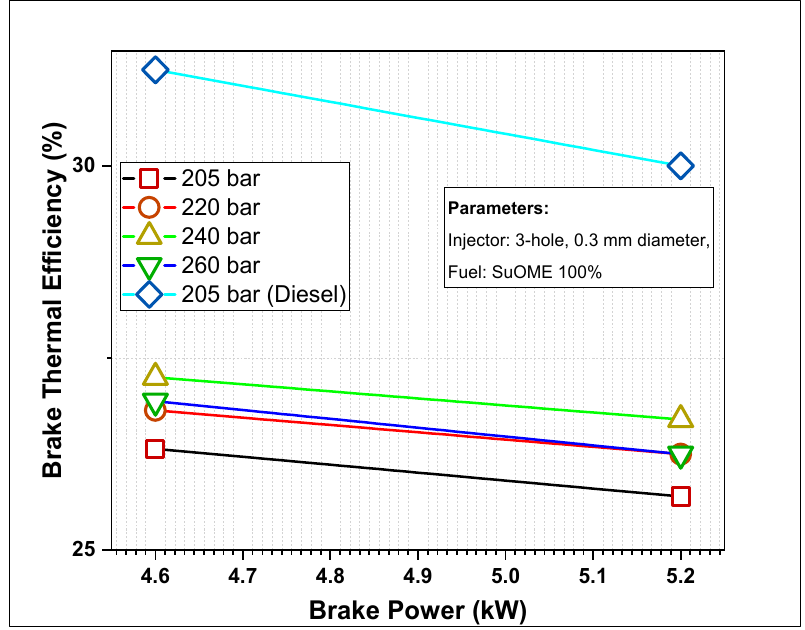
Figure 3. Variations of brake thermal efficiency over brake power.